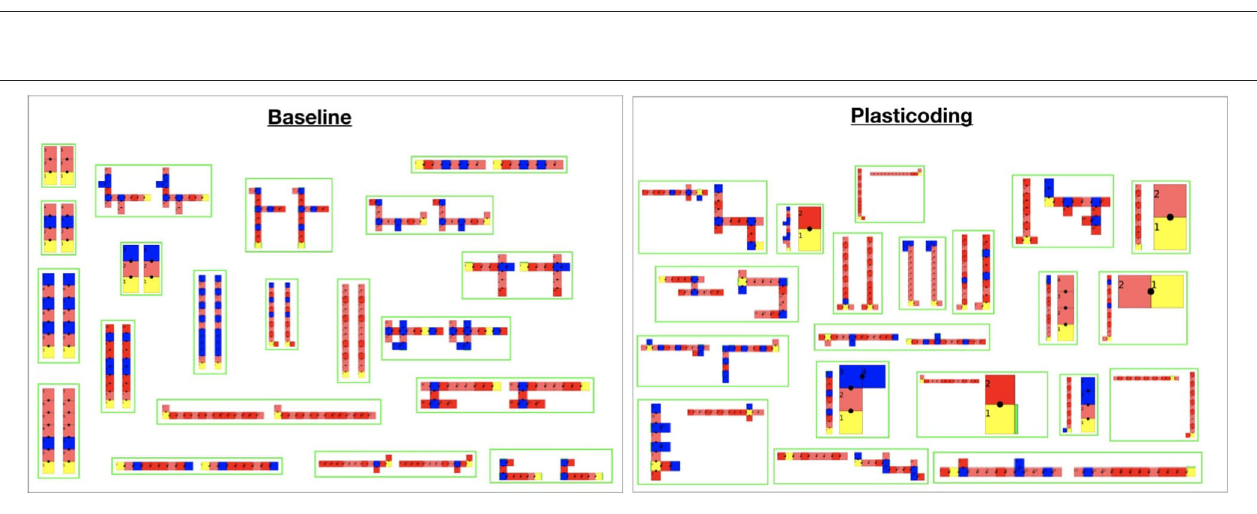
Frontiers in Robotics and AI | www.frontiersin.org